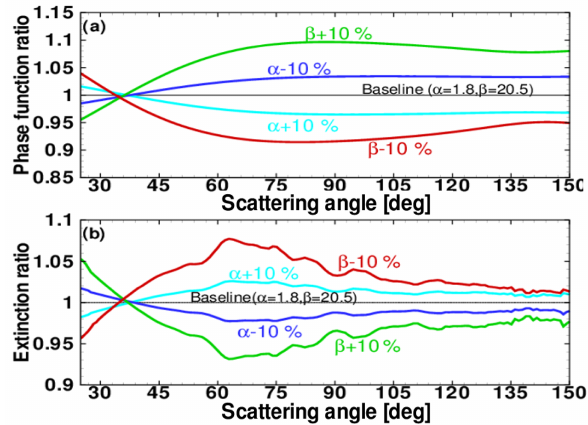
Figure 3. This figure shows how simulated phase function and re- trieved extinction change when α and β are perturbed by ± 10% of the baseline values ( α = 1 . 8 and β = 20 . 5). All the phase functions and the extinctions shown are divided by the baseline data (black lines). (a) Ratio of the perturbed phase function to the baseline phase function. (b) Ratio of the perturbed extinction to the baseline extinction. The extinctions are retrieved using the simulated phase function and OMPS/LP measurements at 20.5km for a single orbit on 12 September 2016. Note that the two curves are roughly anti- correlated, but the fractional change in extinction is about half of the change in P((cid:50)) depending on the single scattering angle (cid:50) . (From Chen et al., 2018.)